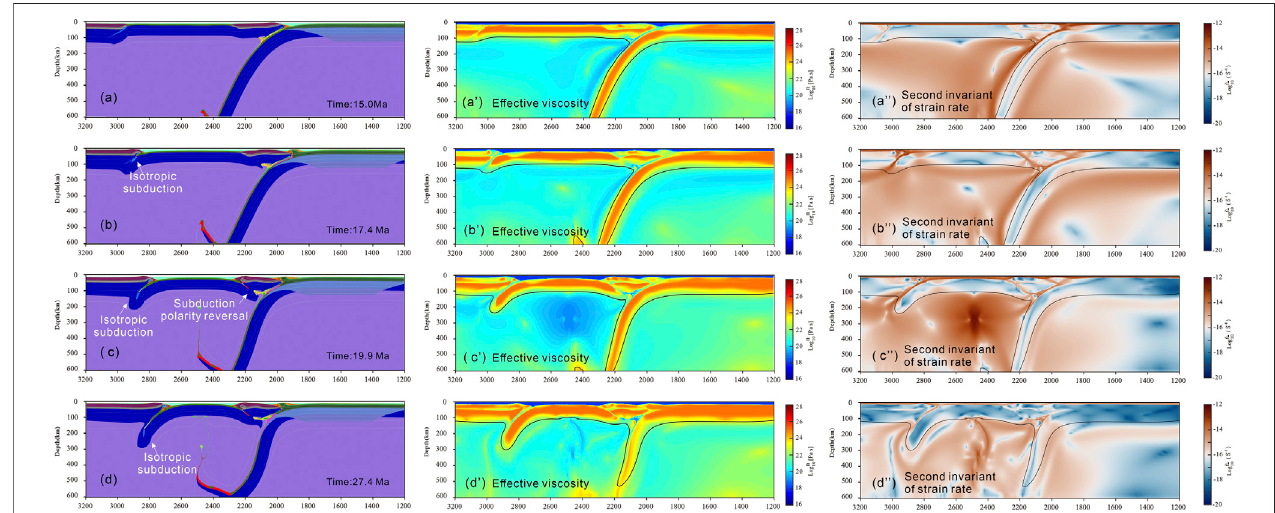
FIGURE 6 | Evolutionary process of Model 3. Panels (A – D) , (a ’ -d ’ ) , and (a ’‘ -d ’‘ ) show rock composition, effective viscosity, and second invariant of the strain rate at different time steps, that is, 15.0, 17.4, 19.9 and 27.4 Ma, respectively. The color bars of viscosity and strain rate are shown on the left, while the color bar of composition is shown in Figure 2